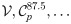
Classification accuracy for the expert, the simulated citizen scientist annotations, and the CS primer-experiment.a) Shows the accuracies aggregated by experiment and b) Each boxplot represents the aggregated results from each dataset (V,Cp87.5,…) for each specific taxon.